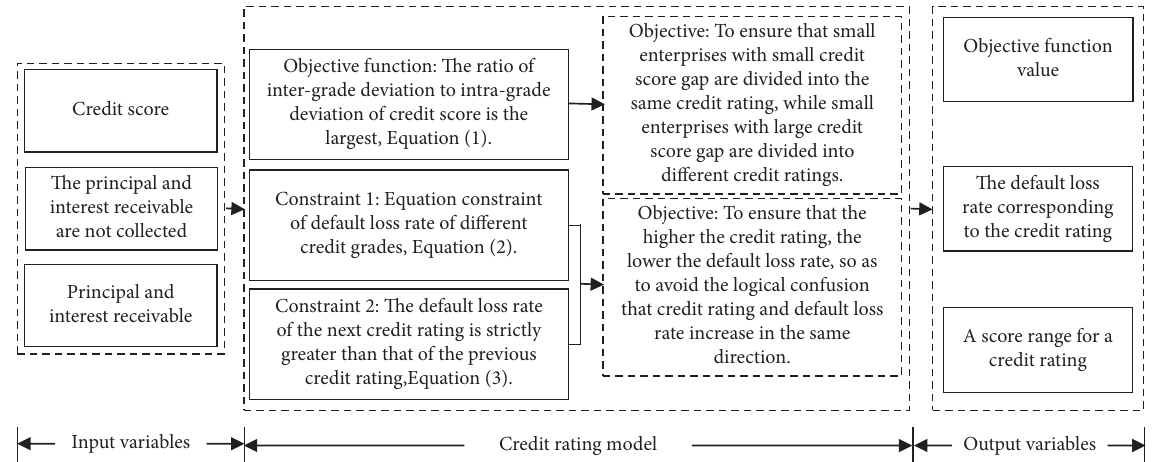
Figure 1: The principle of credit rating model for small enterprises based on optimal discriminant